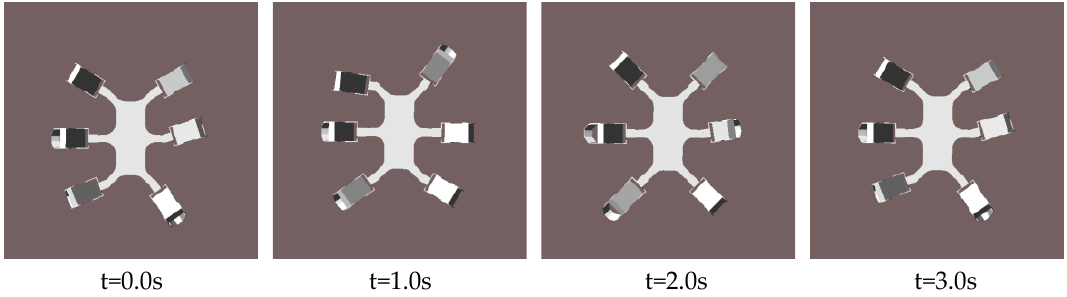
Figure 20. Vertical view of one period simulation sequence with leg 2 fault.